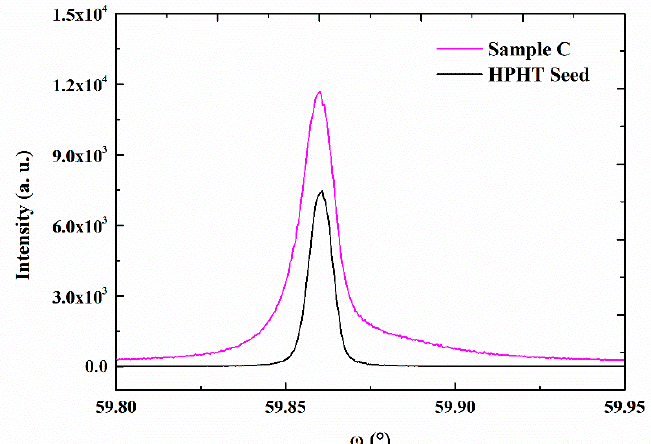
Figure 8. XRD (400) ω scan of high-pressure high-temperature (HPHT) diamond seed and Sample C showing the crystalline quality of diamond film comparable to HPHT diamond seed.